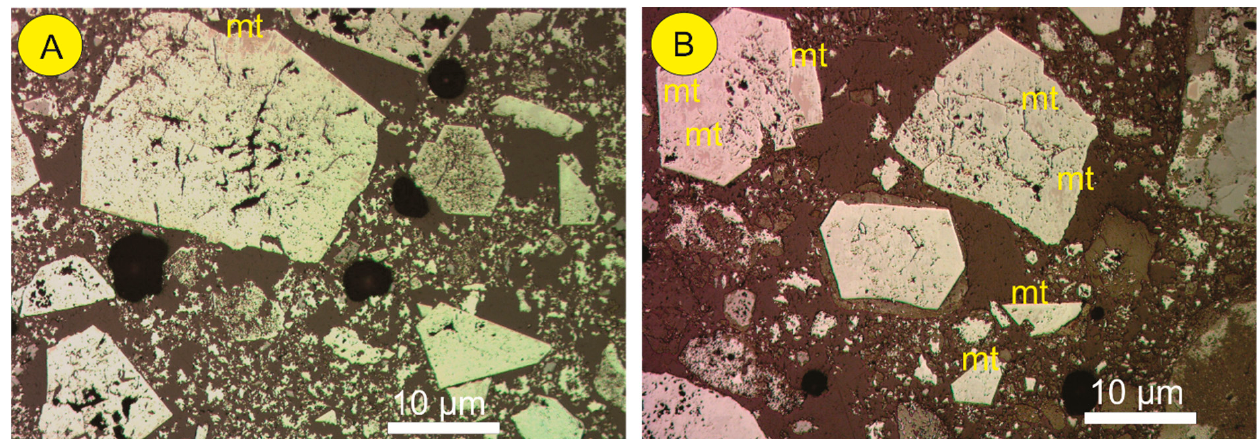
Figure 5. ( A ) N4WN polished section exhibiting predominance of hematite (light gray) grains and few magnetite domains (mt, pinkish gray); ( B ) N4WS polished section, here the magnetite domains (mt, pinkish gray) are more abundant than in N4WN.